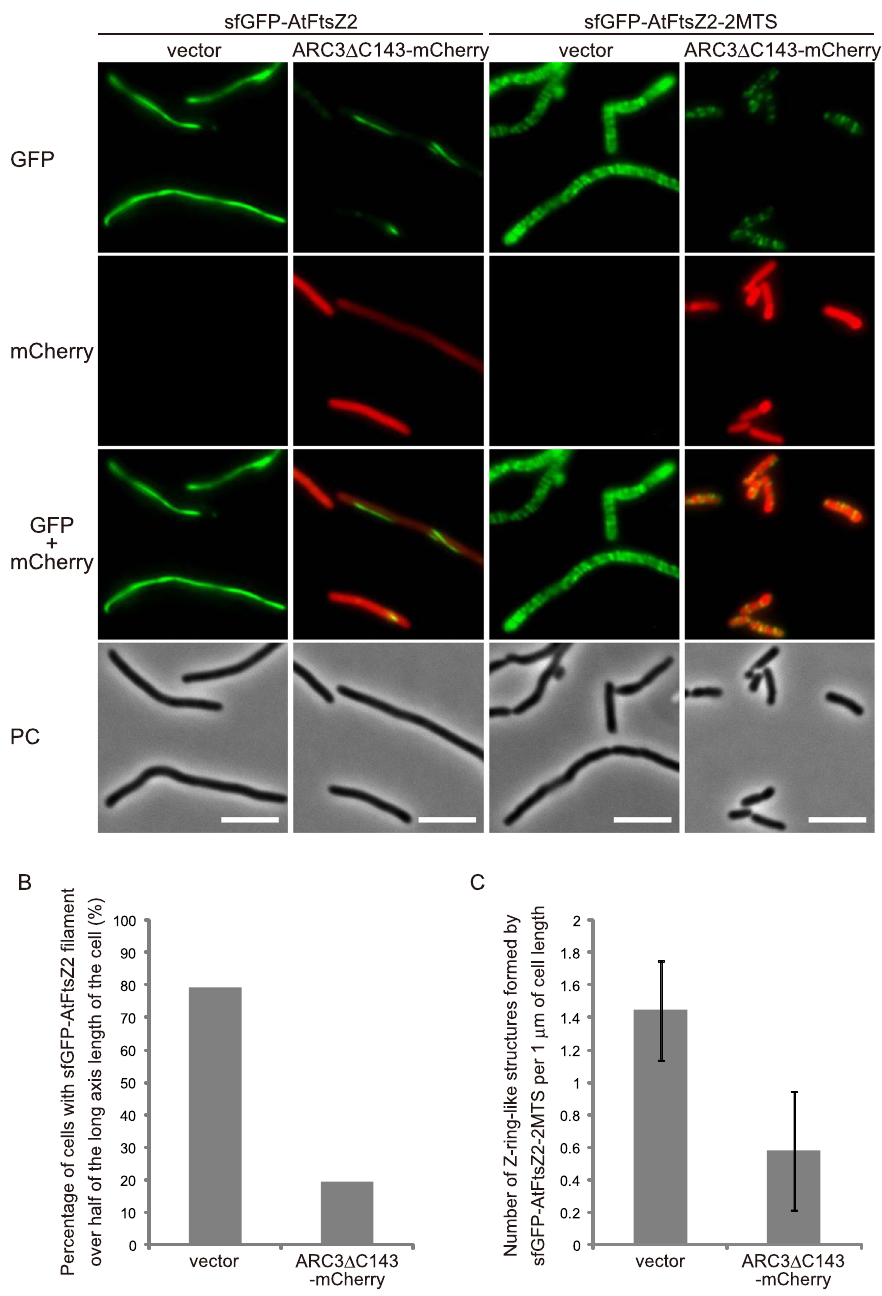
Figure 3. Stromal protein ARC3 exerts inhibitory effects on FtsZ assembly in E. coli cells. ( A ) Effect of ARC3 expression on AtFtsZ2 filaments and Z ring-like structures. Scale bar: 5 μ m. ( B ) Quantification of ARC3 inhibition of AtFtsZ2 filament formation. The graph shows the percentage of cells containing sfGFP-AtFtsZ2 filaments that extended over half the cell length along the long axis. At least 118 elongated bacterial cells were investigated for the quantification. ( C ) Quantification of ARC3 inhibition of AtFtsZ2 Z ring-like structure formation. The graph shows the number of sfGFP-AtFtsZ2-2MTS Z ring-like structures per 1 μ m of cell length. The mean and standard deviation were calculated from at least 89 cell